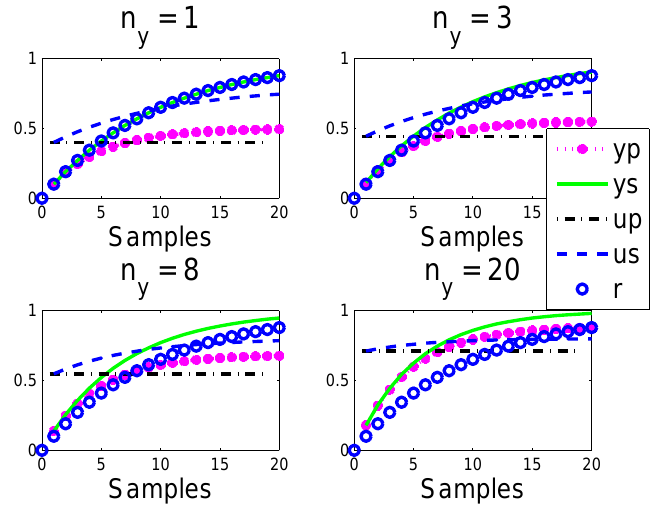
Figure 7. Closed-loop PFC input and output us; ys responses overlaid with predictions up; yp made at the first sample for a < (cid:26)